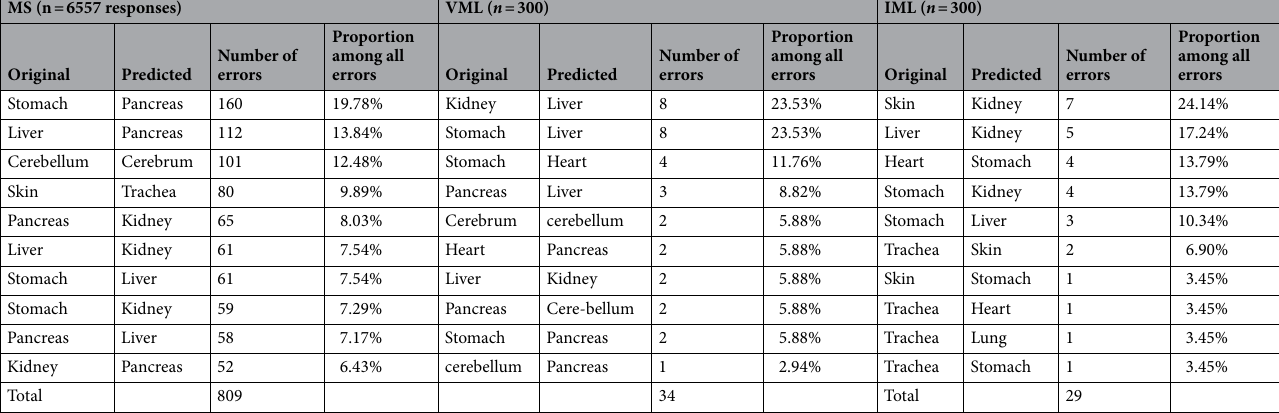
Table 10. Commonest errors of MS, VML & IML model; 66 medical students have provided 6557 responses in a quiz questionnaire of 100 images; the VML and IML model were evaluated on the full validation set ( n =